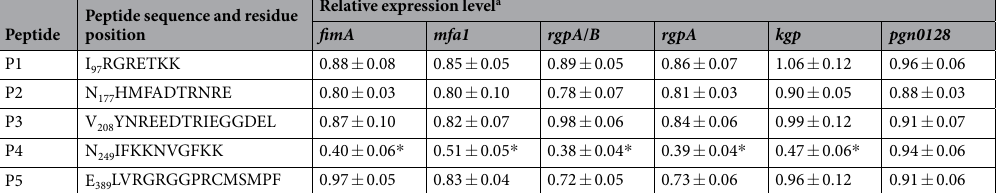
fimbrial subunit, as also shown by others 17 . The half inhibitory concentration (IC50) was determined by con- structing a dose-response curve (0, 4, 16, and 64 µ M) to measure the effectiveness of peptide4 in repressing expression of these genes. As shown in Fig. 5, the highest efficiency of peptide4 was found in inhibition of rgpA (amplified with primers corresponding to the region encoding the binding domain of RgpA, HGP44), rgp A/B (amplified with primers corresponding to the region encoding catalytic regions of RgpA and B), and fimA with IC50s of 11.2 ± 2.1, 11.7 ± 2.3 or µ M, 12.4 ± 3.4, respectively. Peptide4 also showed a significantly lower IC50 for mfa1 (19.2 ± 3.3 µ M) compared to that of kgp (64.3 ± 3.8 µ M). It should be pointed out that peptide1, 2, 3 and 5 (Table 1) also exhibited some inhibitory activity, although at a lower efficiency. These regions along with peptide4 may be involved in formation of a structural motif that may have a higher binding capacity than peptide4 alone. These findings provide a molecular basis for the future design of inhibitors of P . gingivalis . To verify that PGN_0806 and RagB function as receptors in P . gingivalis - S . cristatus communication, we tested gene expression in the Δ 0806 and Δ ragB strains in the presence or absence of peptide4 and compared these to that in the wild type strain 33277. The results showed that loss of PGN_0806 prevented peptide4-dependent regulation of fimA , mfa1 , rgp , and kgp (Fig. 6a). Although the ragB mutation did not completely block pep- tide4 activity, a significantly reduced inhibitory effect was observed toward all of the target genes. Previously, a two component regulatory system (FimS/R) was identified to be activator of the fimA expression 22, 23 . We thus tested the role of FimS/R in S . cristatus - P . gingivalis cell-cell communication. Although expression levels of fimA and mfa1 were repressed approximately 20 and 4 fold in the fimS and fimR mutants (data not shown), Peptide4 mediated regulation of FimA expression reminded intact in the absence of FimS and FimR (Fig. 6b), suggest- ing FimS/R is not involved in this bacterial cell-cell communication. These results provide strong evidence that PGN_0806 and RagB, either separately or in combination, act as receptors in the bacterial cell-cell communica- tion between P . gingivalis and S . cristatus . Expression of fimbrial proteins and gingipains at the translational level was also determined using Western blot analysis. P . gingivalis 33277 was grown with peptide4 at concentrations of 0, 3, 12, and 48 µ M (0 × , ¼ × ,